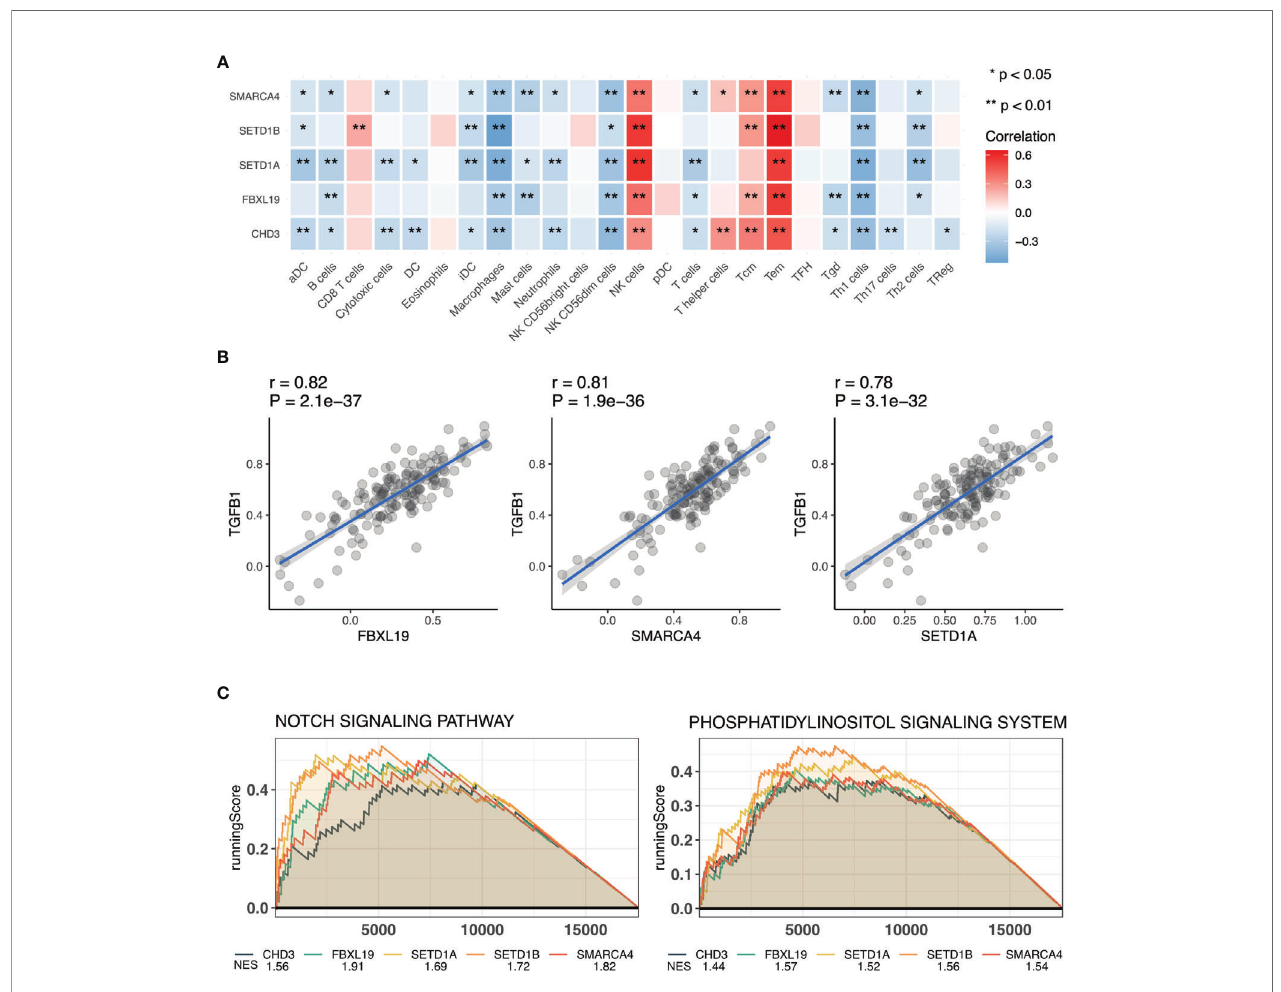
FIGURE 4 | Functional analysis of hub genes. (A) Correlation analysis of hub genes and immune cells. (B) Scatter plot of correlation analysis of hub genes and transforming growth factor-beta (TGFB1). (C) Functional gene-set enrichment analysis (GSEA) of hub genes. *, P<0.05 and **, P<0.01